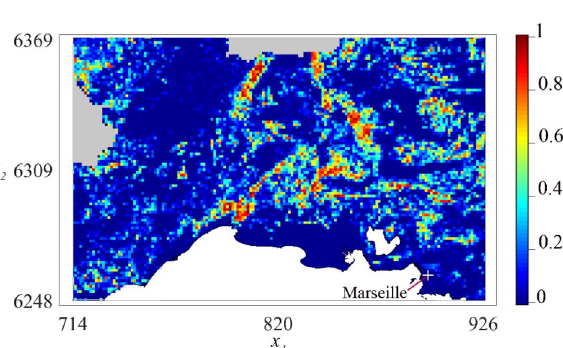
Figure 1. Approximated density z ( x ) of the host plants in the study area. The density was normalized, so that z ( x ) z ( x x 0 corresponds to an absence of cucurbit plants and z ( x ) 1 , 2 ) = = axes x 1 and x 2 correspond to Lambert93 coordinates (in km). The white regions are non-terrestrial habitats (water). Land use data were not available in the gray regions; the host plant density was then computed by